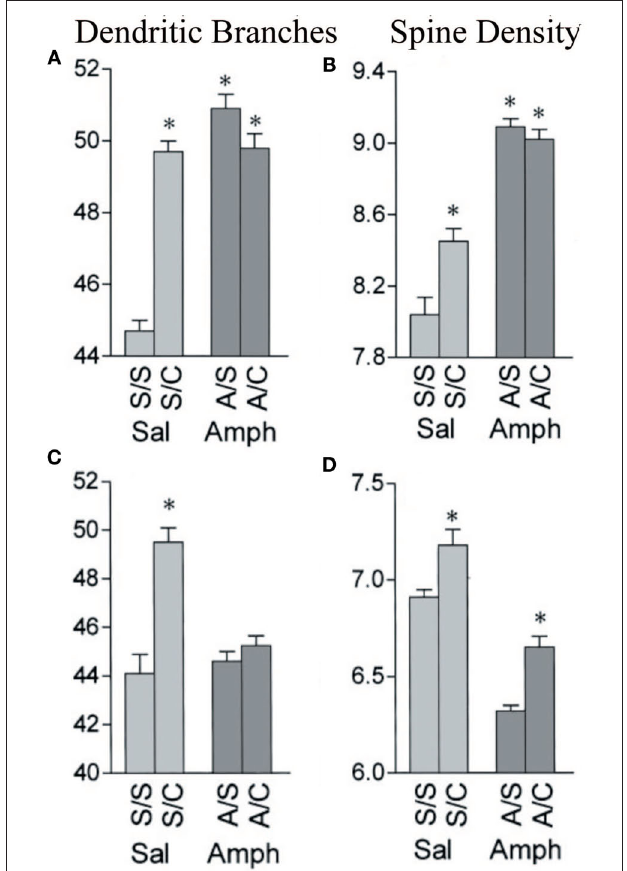
FigurE 1 | Effects of amphetamine and complex housing on dendritic branches (A,C) and spines (B,D) on both apical (A,B) and basilar (C,D) of layer III pyramidal cells in parietal cortex. Branching: complex housing (C) increased the number of both apical and basilar branches, but amphetamine (A) had no effect. Prior amphetamine completely blocked the effect of housing in the complex environment. Spines: complex housing increased the number of spines and amphetamine decreased density. Spine density remained lower in the amphetamine group (A/C) than in the control group (S/C) (after Kolb et al.,